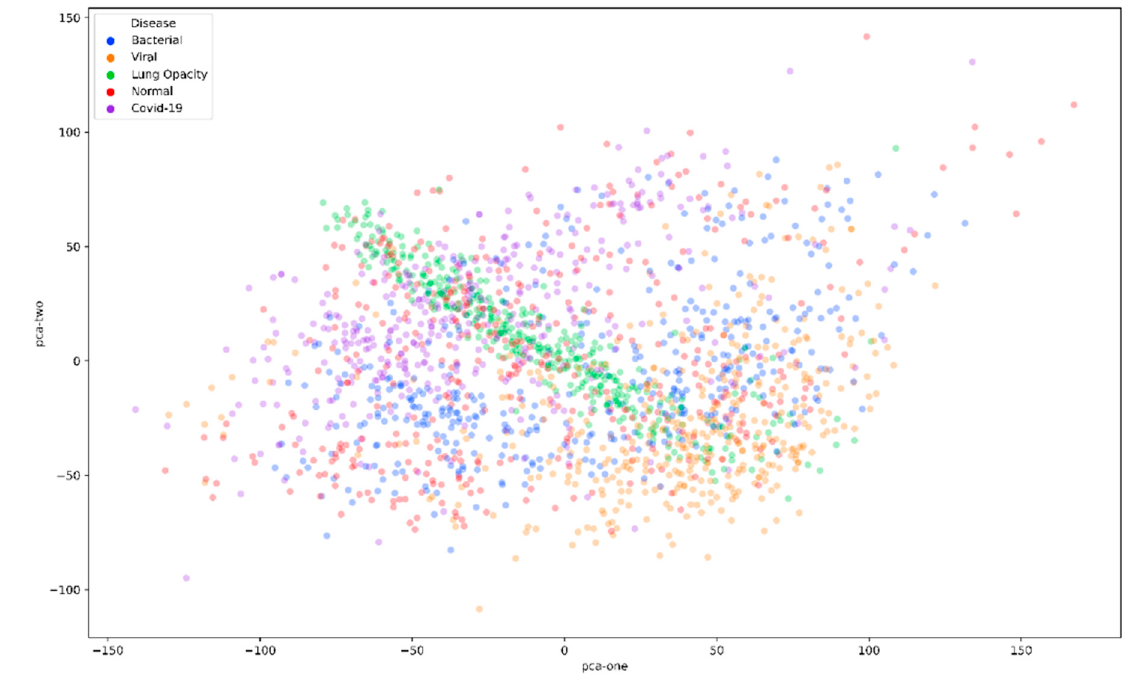
Figure 8. PCA results.